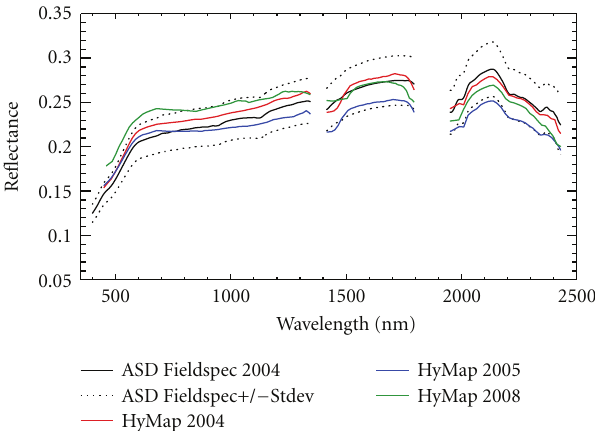
Figure 4: Comparison of mean reflectance spectra of a concrete area on a farm premise near the city of Kruckow acquired with an ASD Fieldspec Pro in 2004 and the HyMap sensor in 2004, 2005, and